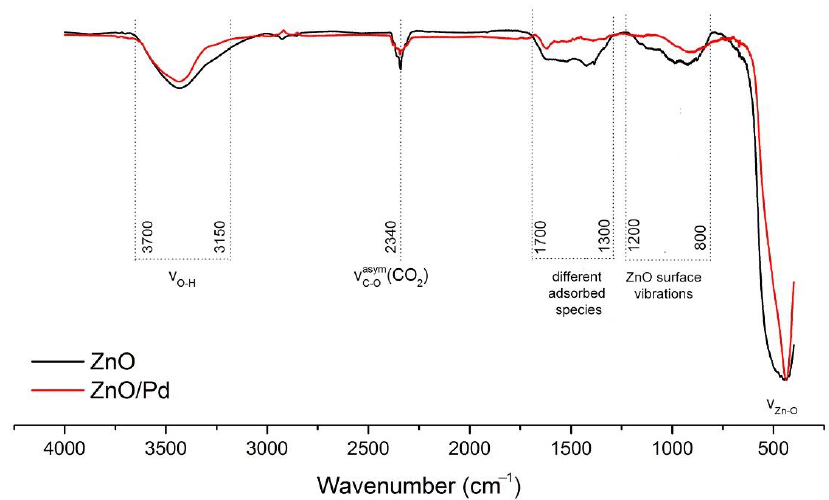
Figure 5. FTIR transmission spectra of ZnO and ZnO/Pd nanofibers.